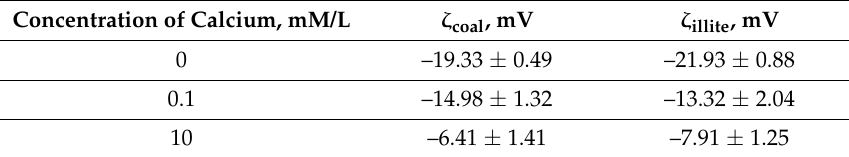
Table 3. The zeta potential of samples under different calcium concentration at pH 8.2.